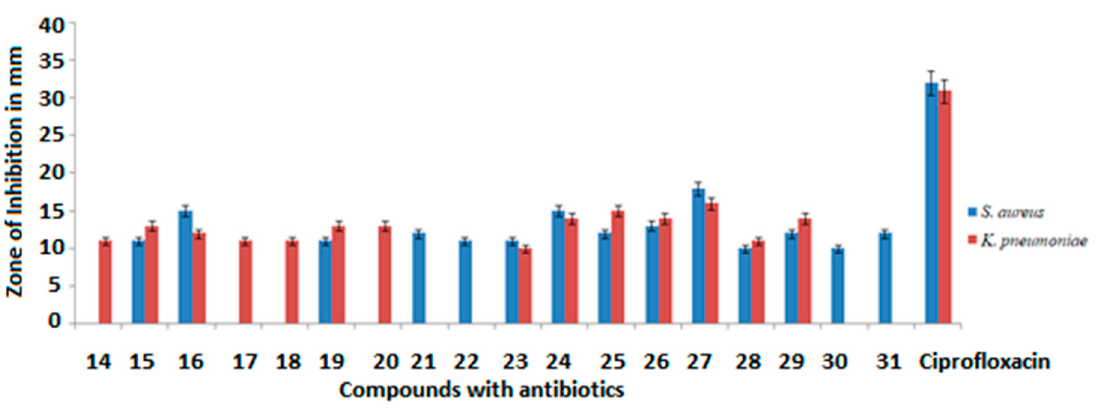
Figure 5. Zone of inhibition of pyazolo[3,4- b ]pyridine and triazole molecular hybrids.